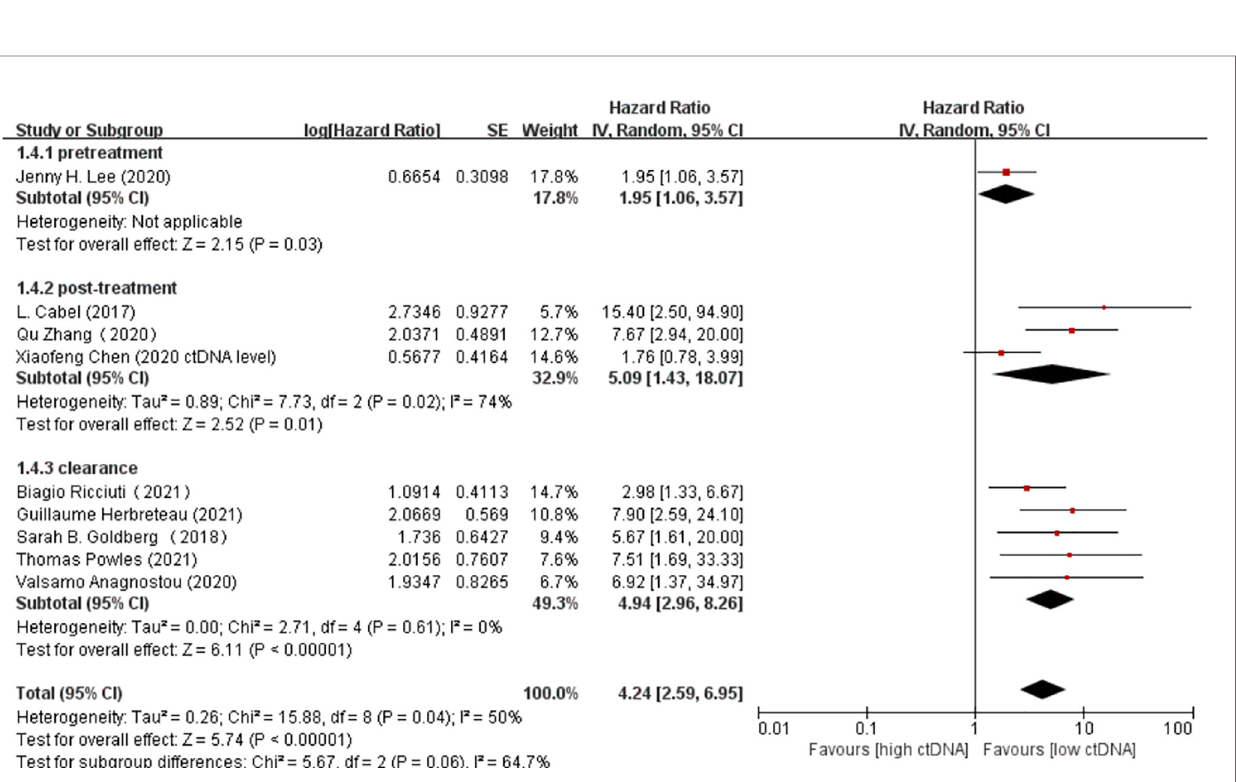
FIGURE 4 | (A, B) Forest plots of the fi xed effects meta-analysis on the ef fi cacy of circulating tumor DNA (ctDNA) for overall survival (OS) (A) and for progression- free survival (PFS) (B) .